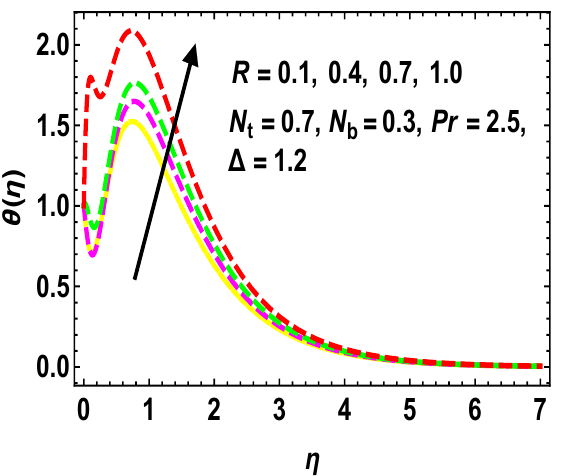
Figure 14. Outcomes of φ ( η ) for N t where yellow, magenta, green, and red lines represent for N t = 3.0, N t = 3.3, N t = 3.6, and N t = 3.9 respectively.